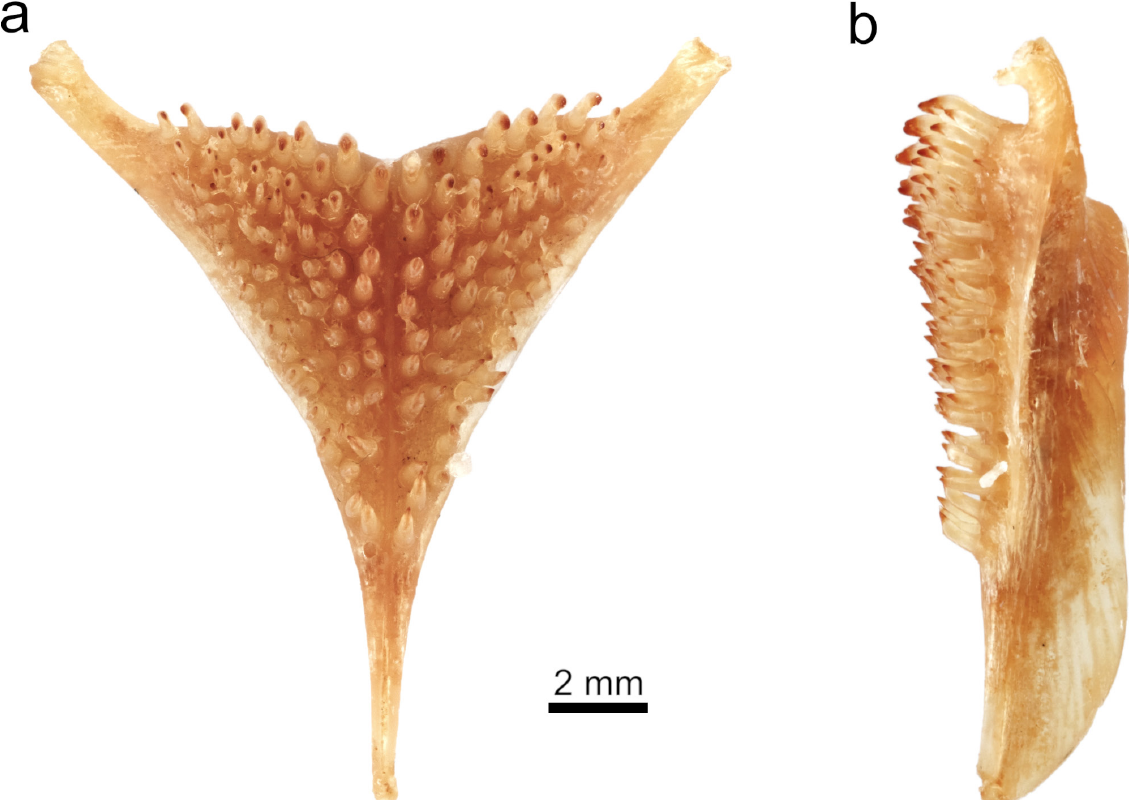
Fig. 13. Haplochromis rex sp. nov. (IRSNB 13480; 154.2 mm SL). a . Dorsal view of the lower pharyngeal jaw. b . Lateral view of the lower pharyngeal